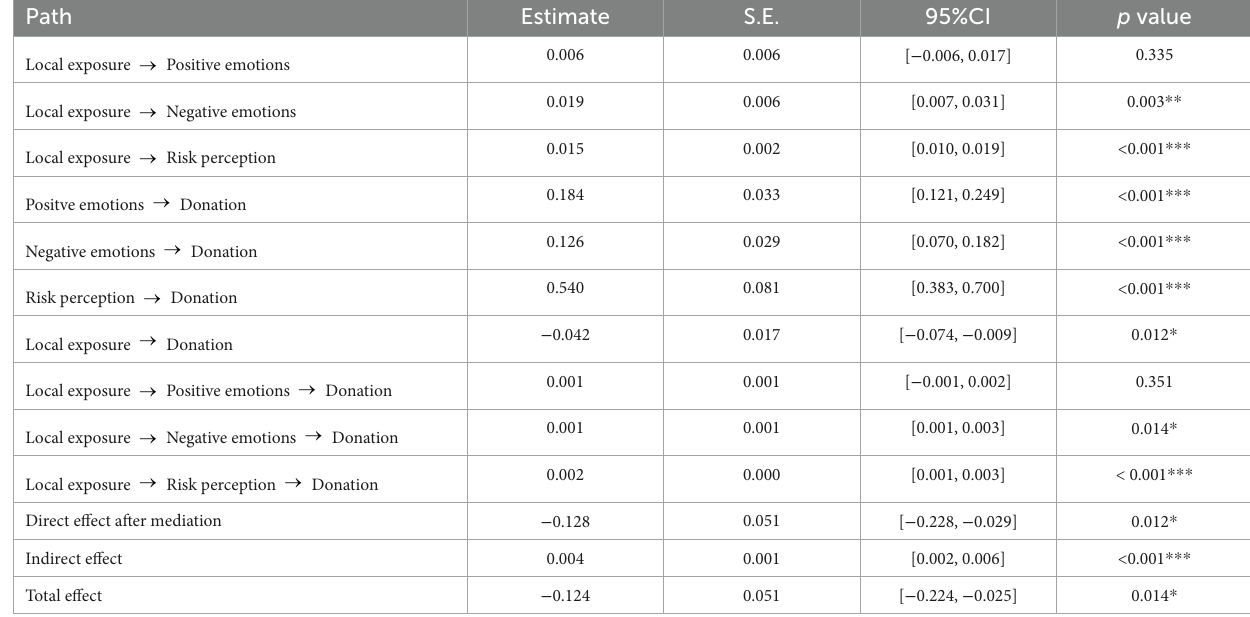
TABLE 5 The mediation analysis on the relationship between local exposure and donation behavior with positive emotions, negative emotions, and risk perceptions as mediators.